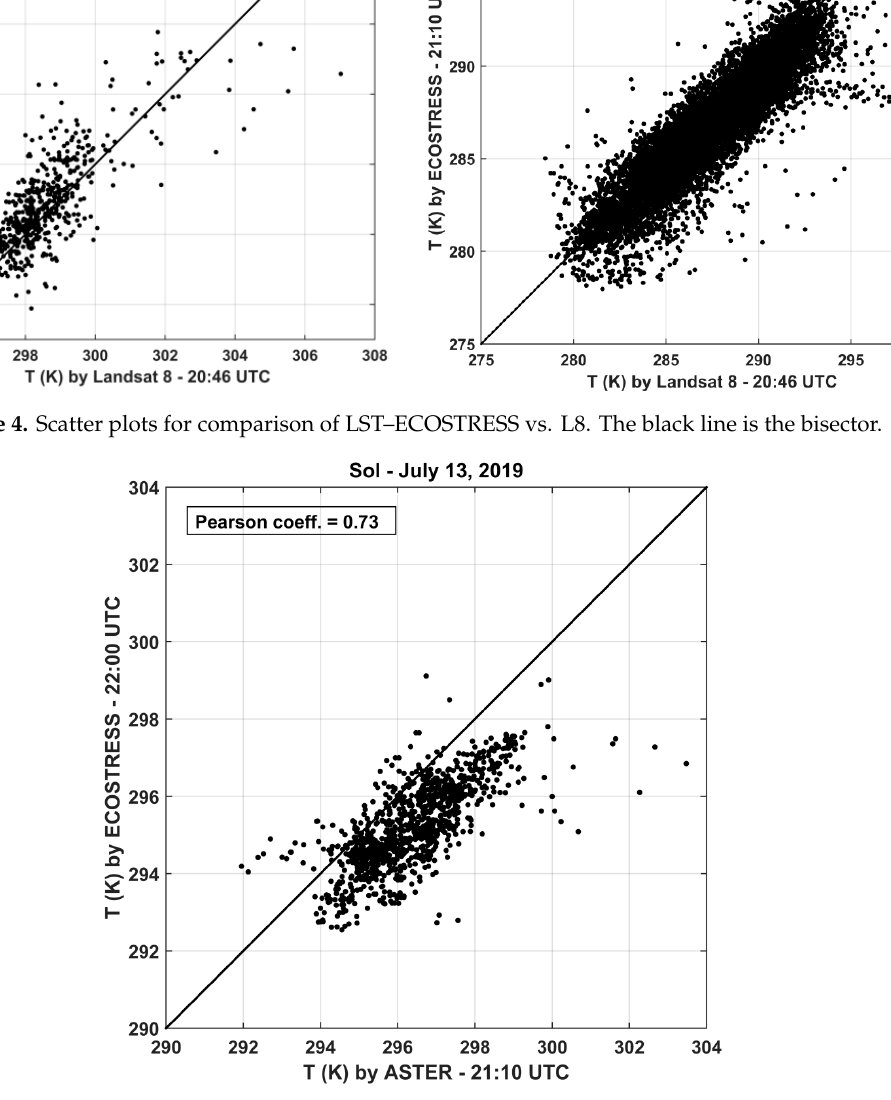
Figure 5. Comparison of LST–ECOSTRESS vs. ASTER. The black line is the bisector. The resulting values of the Pearson coefficient, bias, and RMSE computed for each pair of images are reported in Table 4. Table 4. Results of statistical analysis. RMSE: root mean square error. Positive and negative values of Bias represent ECOSTRESS overestimation and underestimation, respectively.